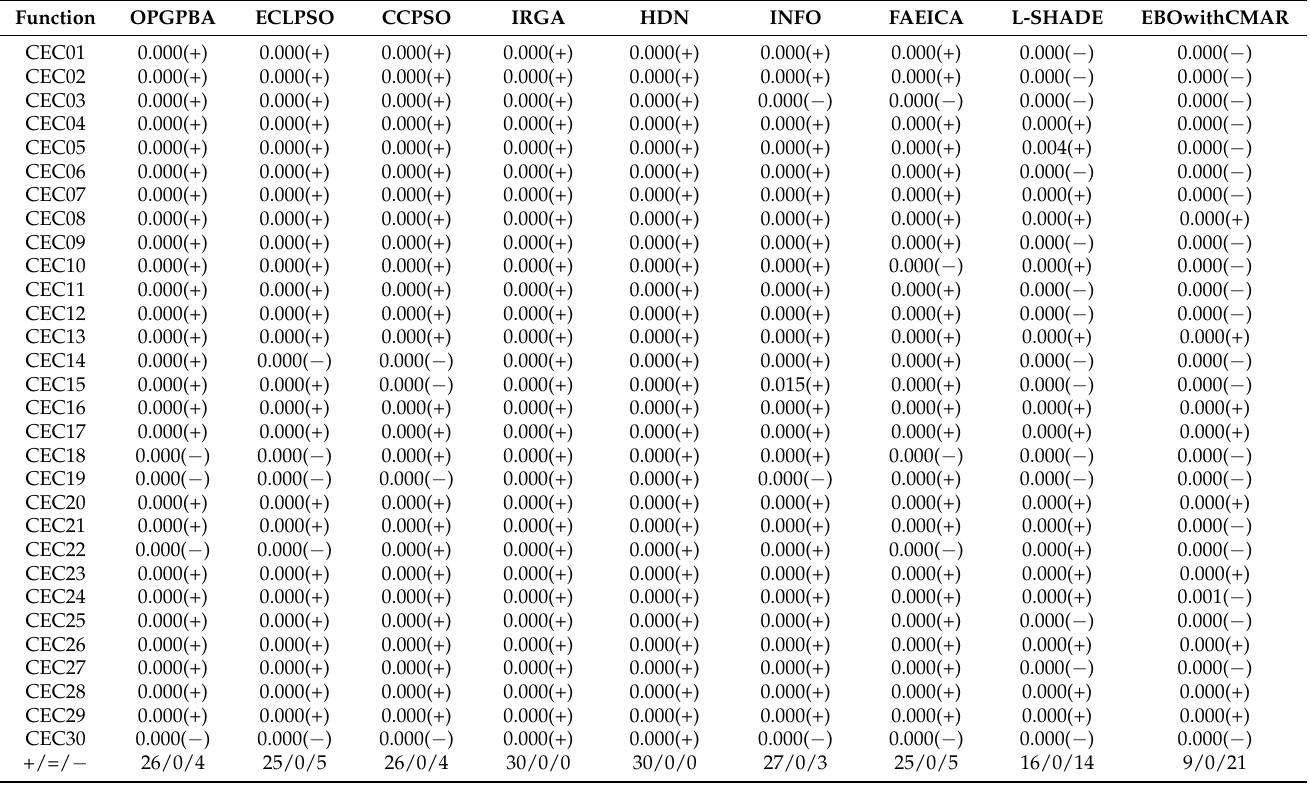
Table 13. Wilcoxon signed rank test results ( p -values) of 100-D CEC2017 problem